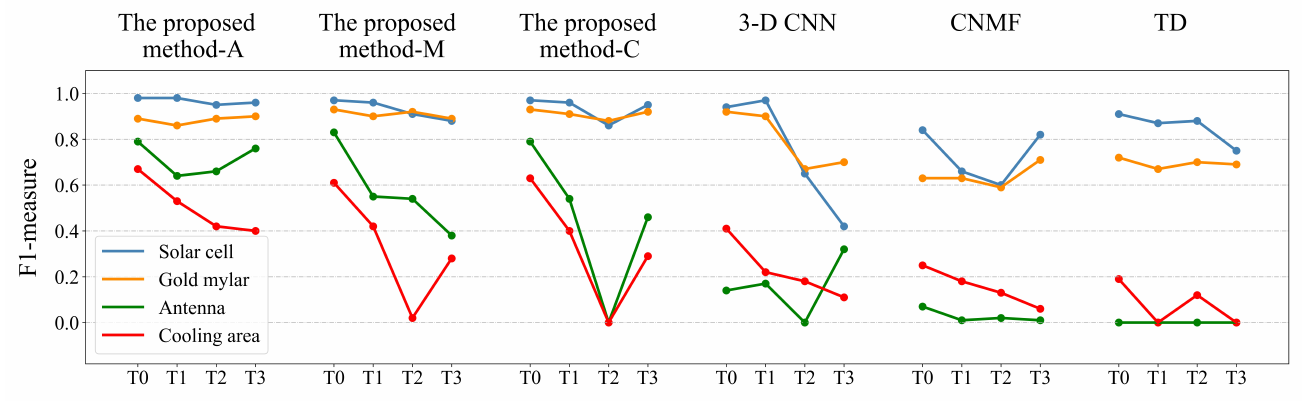
Figure 18. F1-measure chart of the measured data. Table 7. Identification performance table of the measured data (OA-AA-KAPPA).